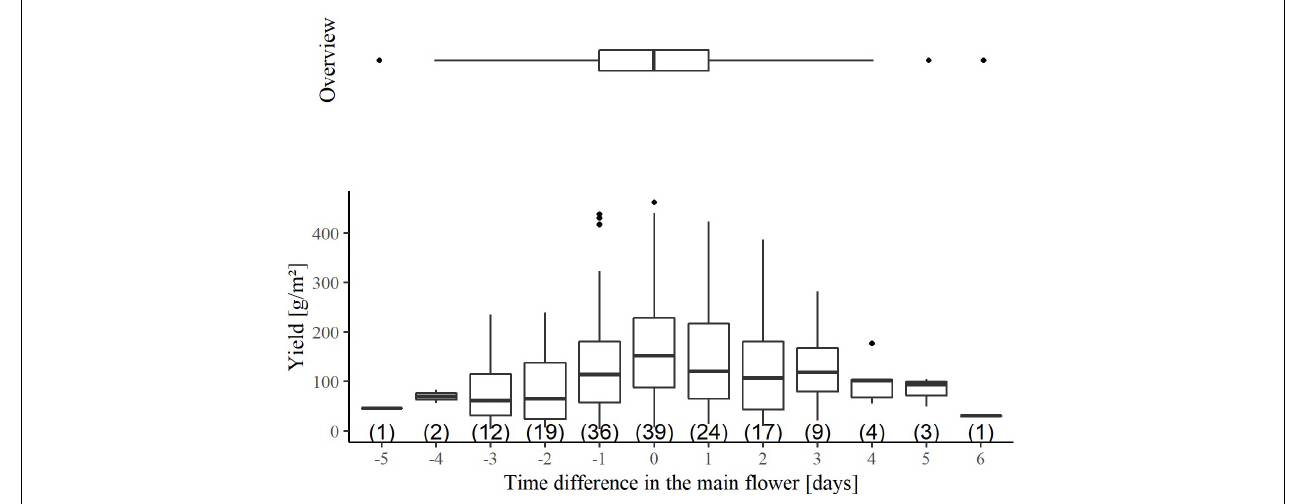
FIGURE 1 | The association between the hybrid seed yield of the female lines and the time difference of the main flowering between the crossing partners in the hybrid seed production experiment. The temporal difference results from subtracting the time of the main flowering of the male and the female. Negative values indicate that the main flowering of the male was earlier than that of the female. Conversely, a positive time difference stands for a later flowering of the male than the female. The horizontal boxplot shown above, summarizes the total variation for the time difference in main flowering. The number of observations per boxplot is given in parenthesis.